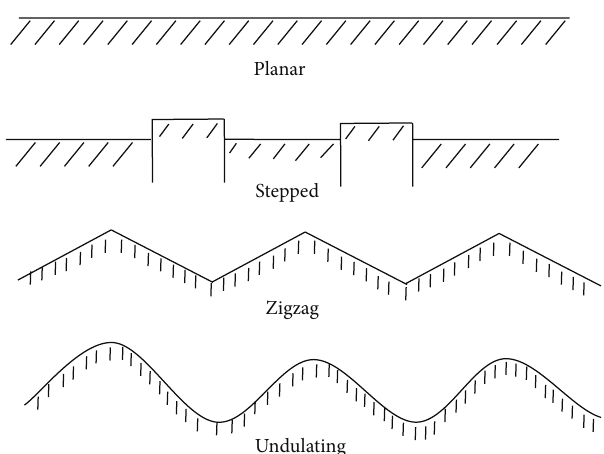
Figure 2: Type of joint undulating shape [8].